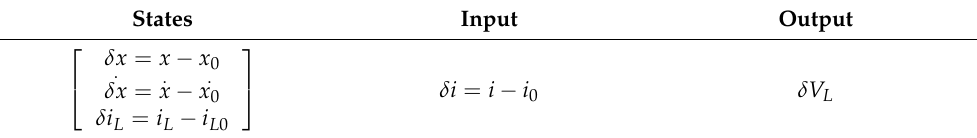
Table 2 summarizes the state variables, inputs and outputs of the linearized system: Table 2. State variables, inputs and outputs summary for the linearized system.